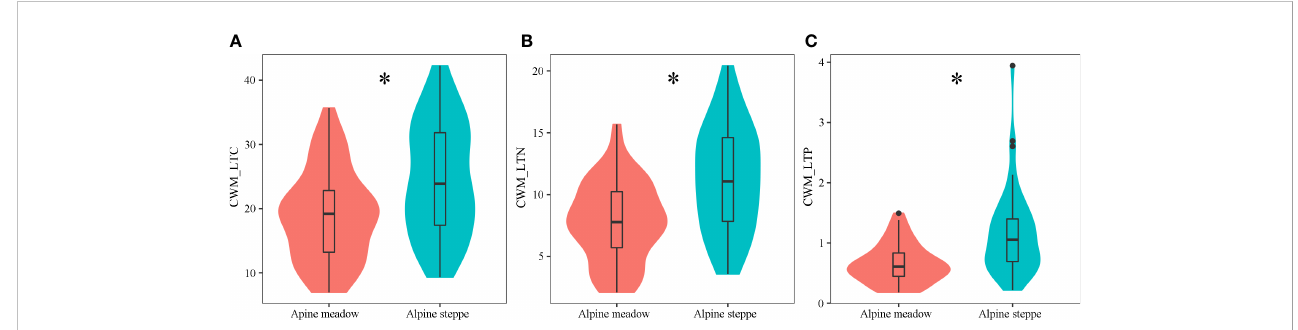
FIGURE 2 Shifts of plant functional traits in different grassland types. Panels (A – C) represent CWM_LTC, CWM_LTN, and CWM_LTP, respectively. The symbol * denotes the signi fi cant differences between different grassland types ( P < 0.05). CWM_LTC, CWM_LTN, and CWM_LTP represent community-weighted mean of leaf total carbon, community-weighted mean of leaf total nitrogen, and community-weighted mean of leaf total phosphorus,